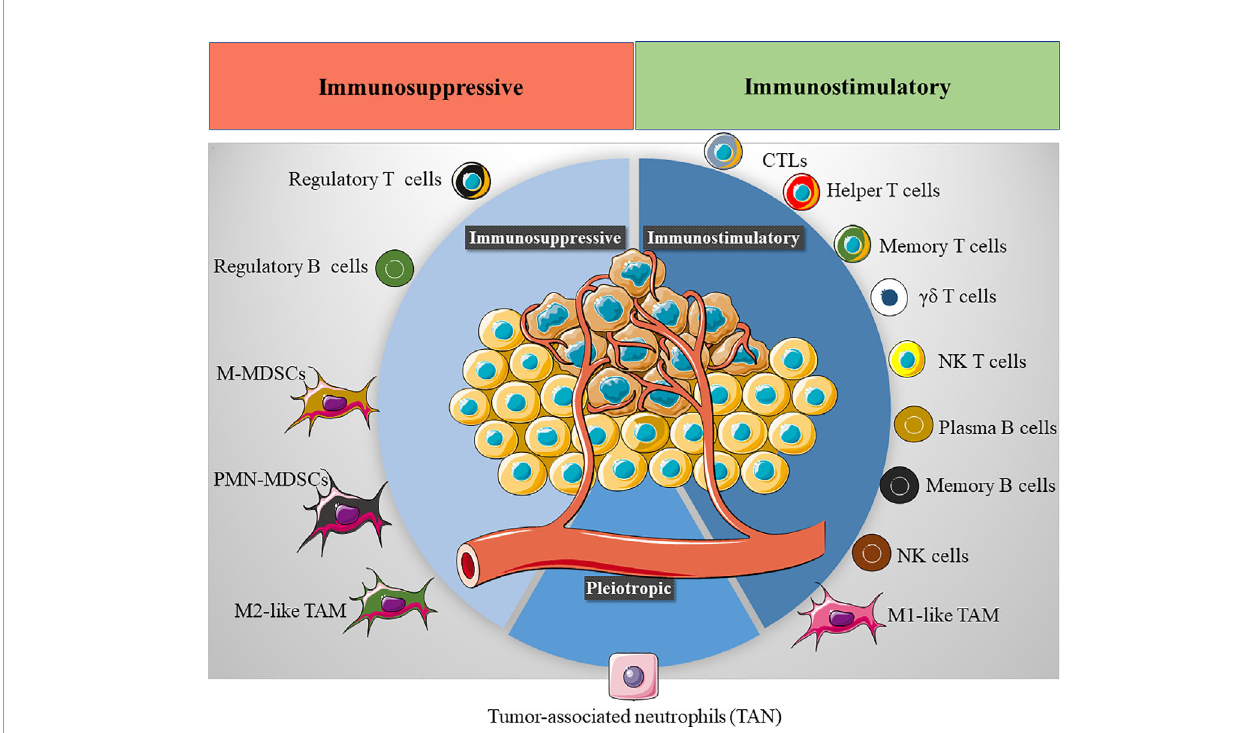
FIGURE 2 | The tumor immune microenvironment (TIME). Several immune cells are found in the TIME, exhibiting either an immunostimulatory (CTLs, cytotoxic T cells, helper T cells, memory T cells, gd T cells, NK T cells, plasma B cells, memory B cells, NK cells and M1-like TAMs) or immunosuppressive phenotype (Tregs cells, regulatory B cells, M-MDSCs, monocytic monocyte-derived suppressor cells, PMN-MDSCs, polymorphonuclear monocyte-derived suppressor cells and M2- like TAMs). The fi nal immunological response in the TME will depend on the balance between these immunomodulatory